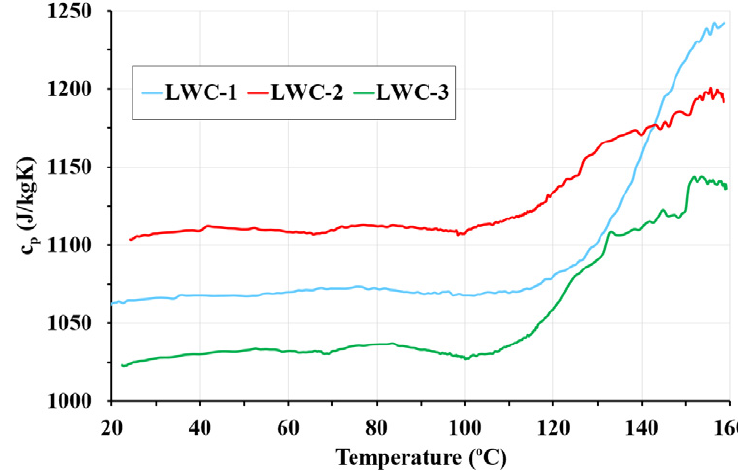
Figure 6. Specific heat for all LWC types.